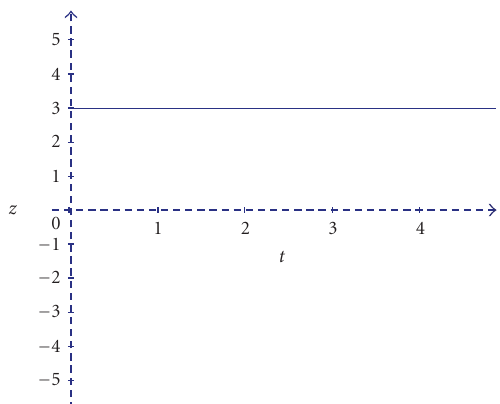
Figure 6.14 . Bounded solution of (5.2) in the point P (50,50), a 0 = 3.